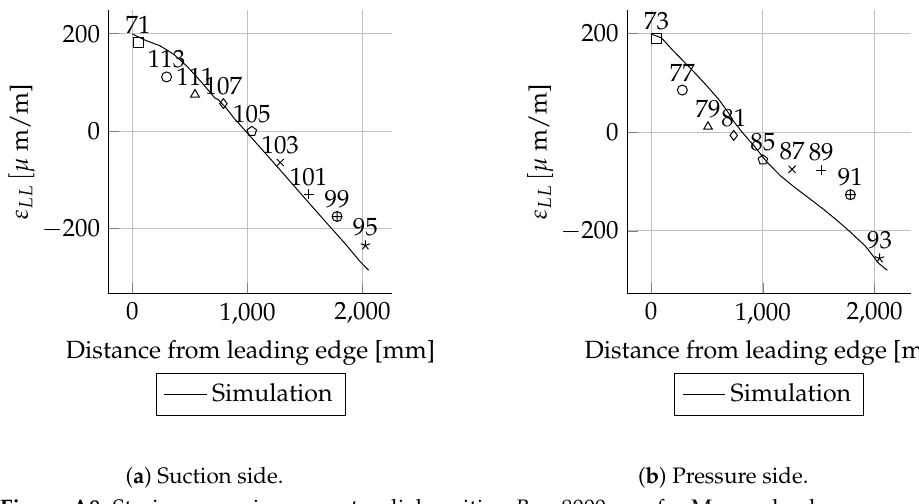
Figure A8. Strain comparison ε TT at radial position R = 8000 mm for Mxmax load